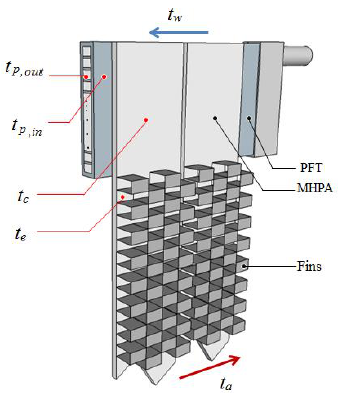
Figure 7. Temperature position of the heat transfer unit.